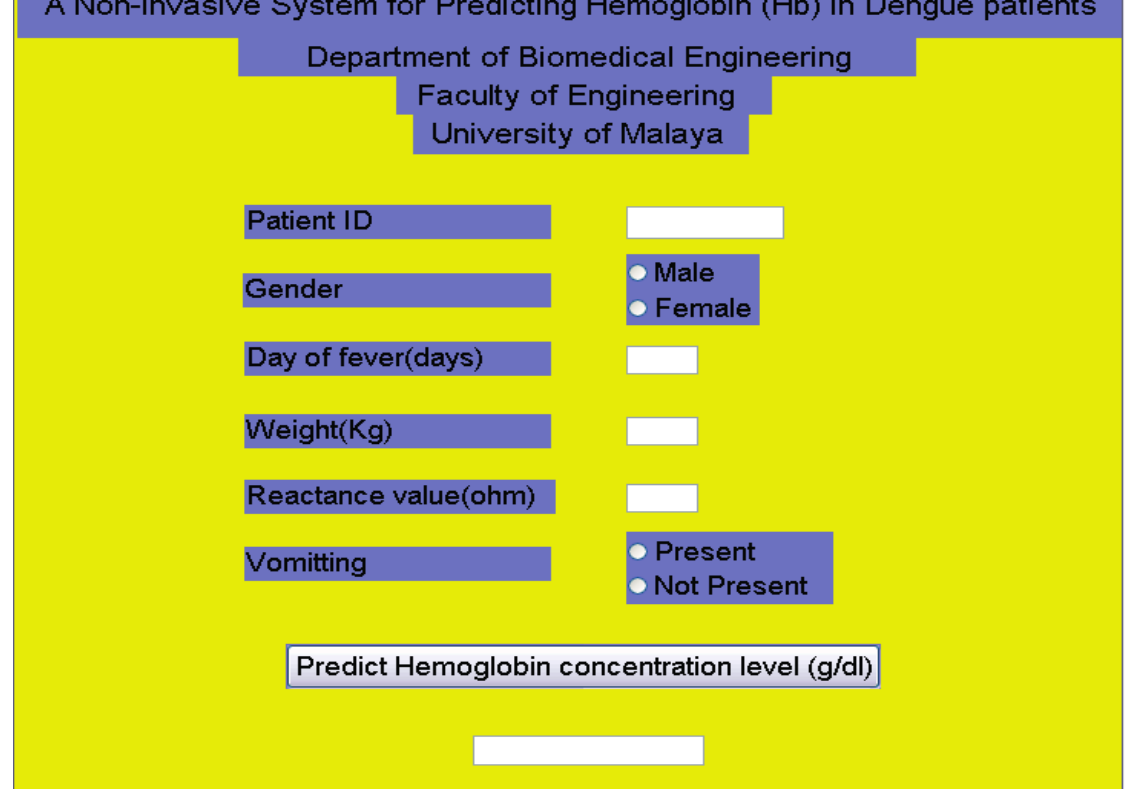
Figure 1. Non-invasive haemoglobin modelling of dengue patients using bioelectric impedance analysis and artificial neural